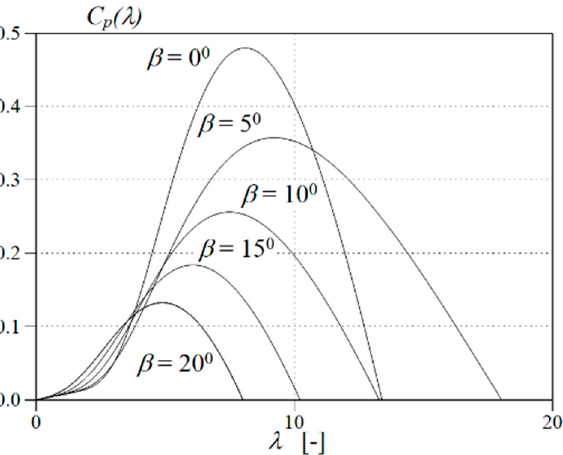
Figure 1. Power coefficient C p ( λ , β ) as a function of the turbine speed ratio for five values of the setting angle.